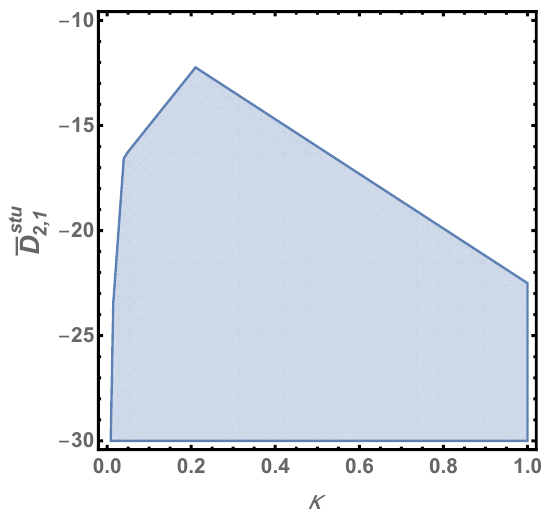
in the positivity 2 , 1 (20 , κ ) . 2 , 1